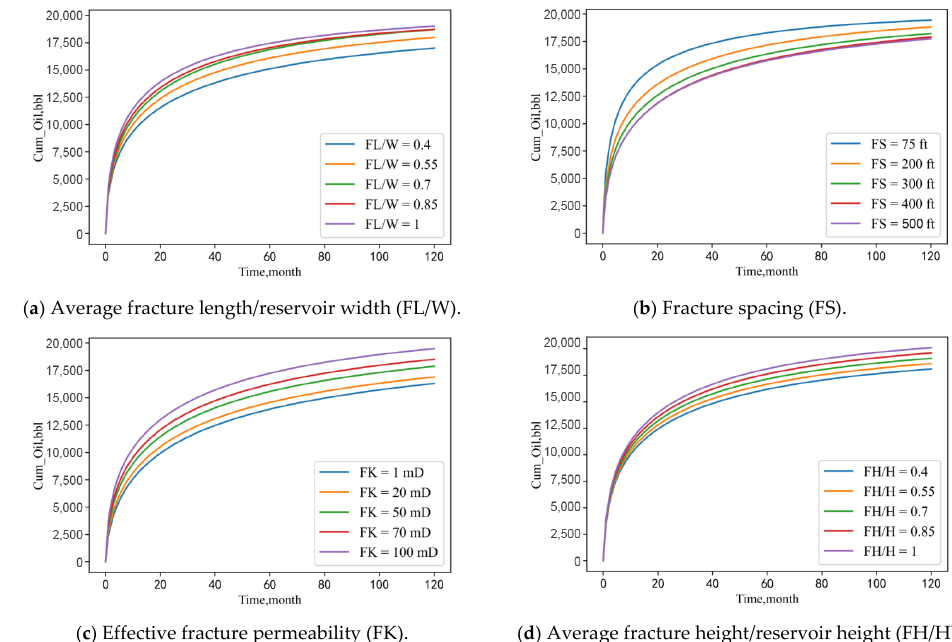
Figure 12. Sensitivity of cumulative oil production to fracturing parameters.